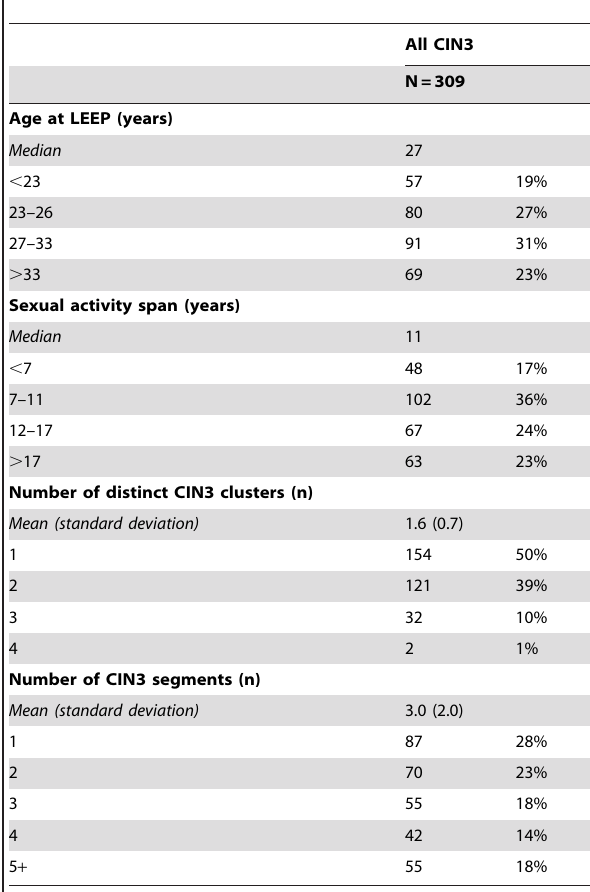
Table 1. Distribution of age, sexual activity span, and number of CINs among women in SUCCEED diagnosed as CIN3 by LEEP (N